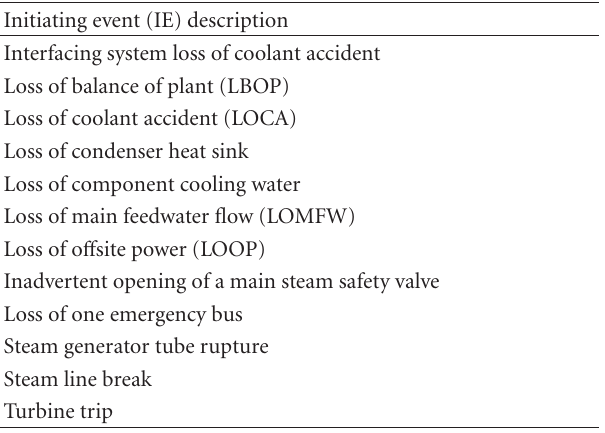
Table 3: Postulated initiating events.